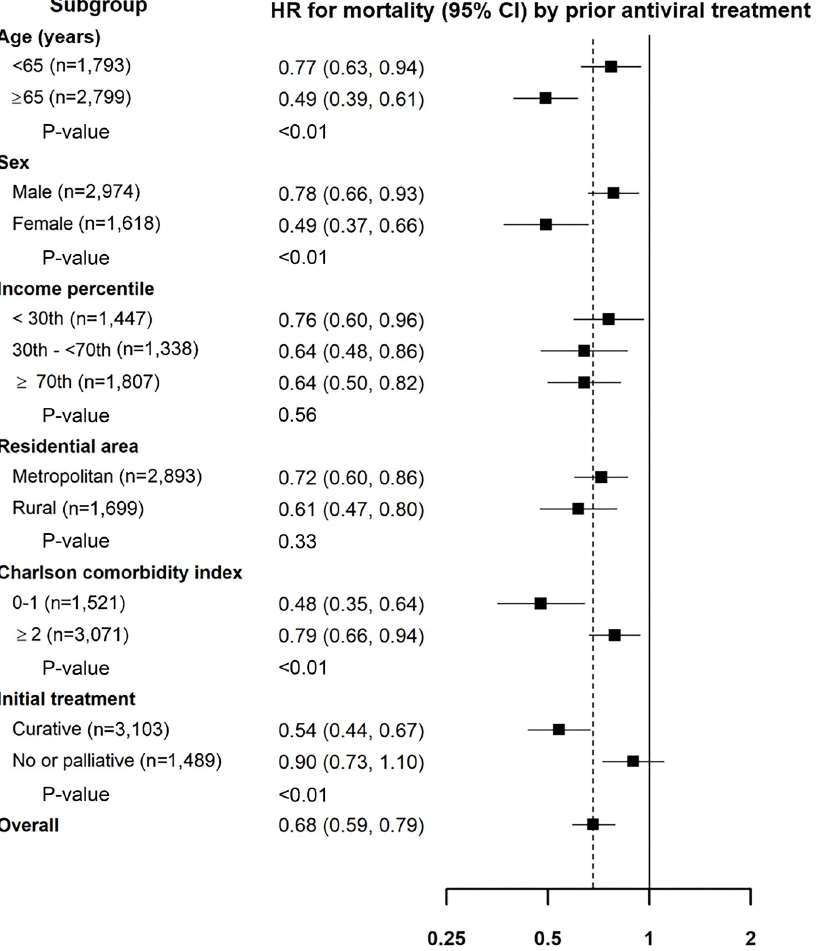
Fig 4. Hazard ratios (95% confidence intervals) for all-cause mortality of patients with hepatitis C virus-related hepatocellular carcinoma according to prior hepatitis C virus treatment in selected subgroups. Adjusted for sex, age, year of hepatocellular carcinoma diagnosis, income percentile ( � 30 th , > 30 th - � 70 th , and > 70 th ), residential area (metropolitan or rural), initial treatment (curative or palliative), and Charlson comorbidity index. (HR, hazard ratio; CI, confidence